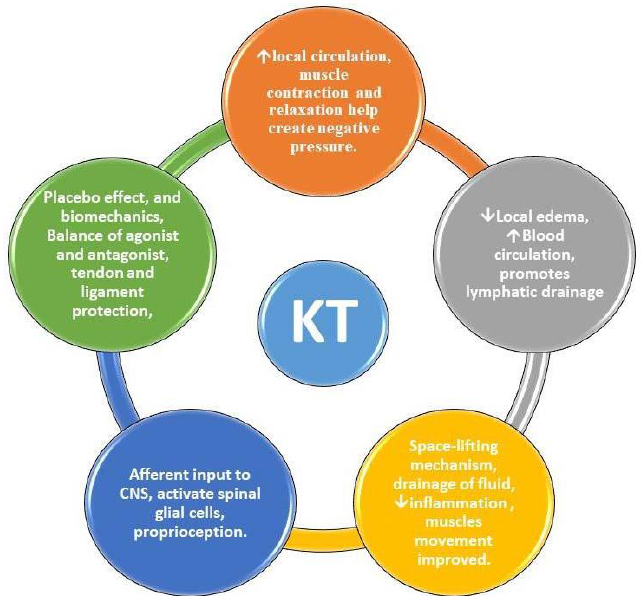
Figure 2. Effects of Kinesio taping on masticatory myofascial pain syndrome. CNS — central nervous system; KT — Kinesio taping.